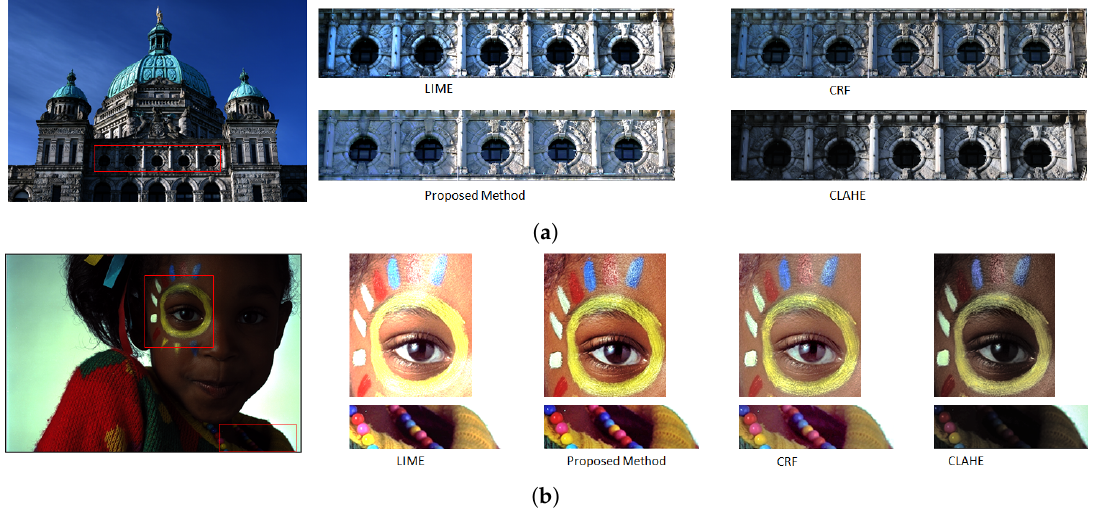
Figure 11. Image contrast enhancement comparison between the proposed method and other